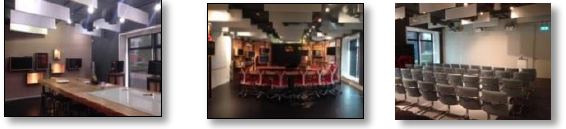
Figure 2: Impressions of different areas in the test facility: Play Zone (left), Business Zone (middle) and Theatre (right) For every test case the performance of the measurements is calculated and localization is performed. One of four scenarios based on the accuracy and precision of the measurements is selected for each of the six test cases. The performance of the location is indicated by the amount of measurements that are located correctly based on the situation described in the test case.